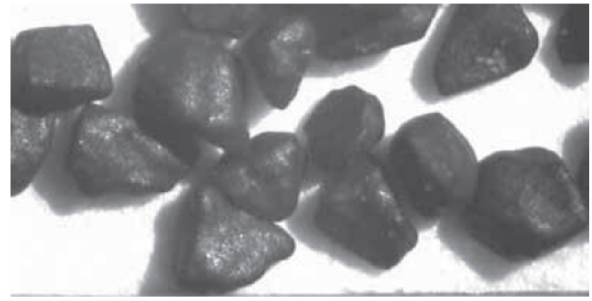
Figure 14. Image of black powder grains [15].